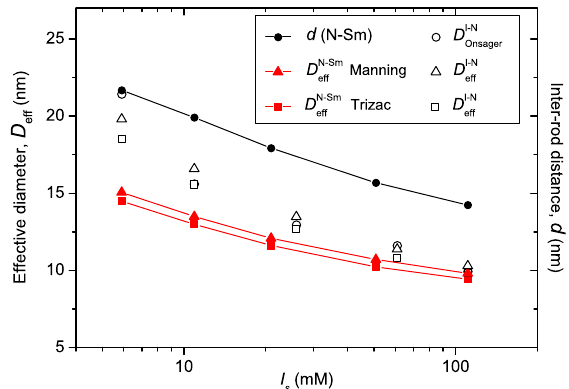
FIG. 4. Effective hard-rod diameter D [Eq. (9)] used for the eff renormalization of the phase diagram (Fig. 3) with the fraction of free ions Q calculated according to the models of Manning [49] (triangles) and Trizac et al. [53] (squares). D at the N-Sm eff transition (red symbols) is shown to always be smaller than the corresponding inter-rod distance d obtained by SAXS (black dots). D at the I-N transition (open symbols) obtained by the eff two charge condensation models described above and from Onsager theory for semiflexible rods [57,60].